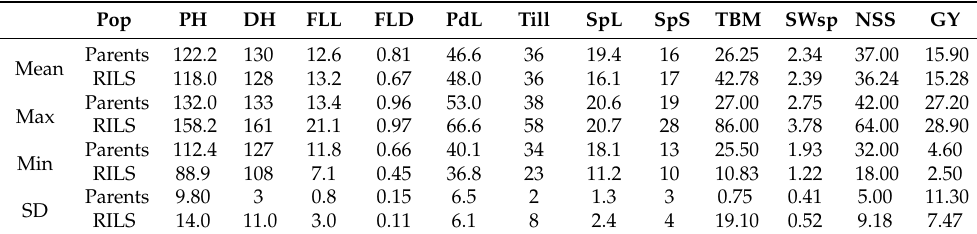
Table 1. Summary Statistics for studied morphological traits of 98 RILS and parents of A-genome